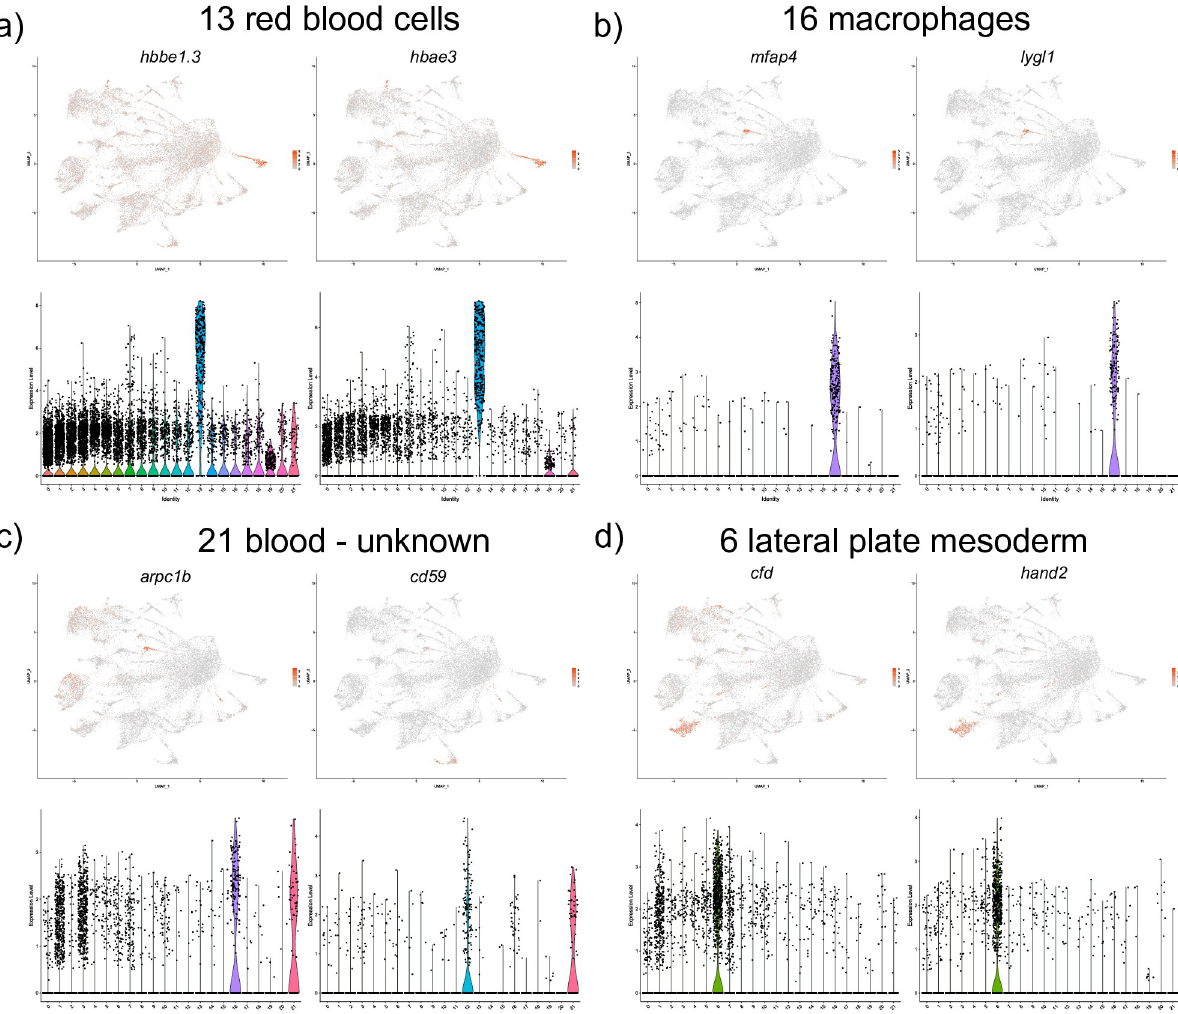
Fig 8. UMAP and violin plots showing the expression of selected marker genes for red blood cells, (cluster #13, a), macrophages (cluster #16, b), blood cells of unknown identity (cluster #21, c) and lateral plate mesoderm (cluster #6, d).